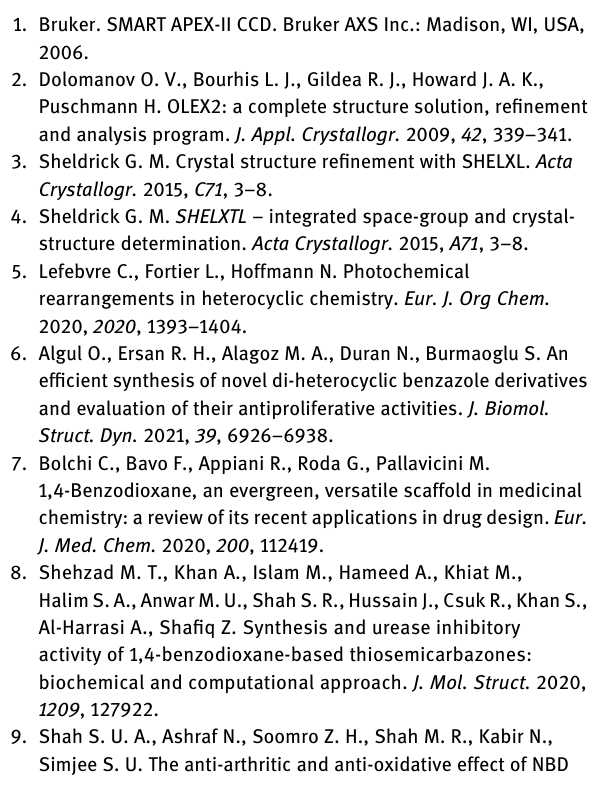
the dihedral angle of the plane A (C9, O1, and O2) and the plane B (C8, C9, and C10) is 90.63 ° . The only intermolecular O4 – H4···O3 hydrogen bond is observed. The O4 – H4 and O3 – H4 bond lengths are 0.8399(15) Å and 1.9385(16) Å. The molecule ’ s structure is similar to the con fi gurations of the